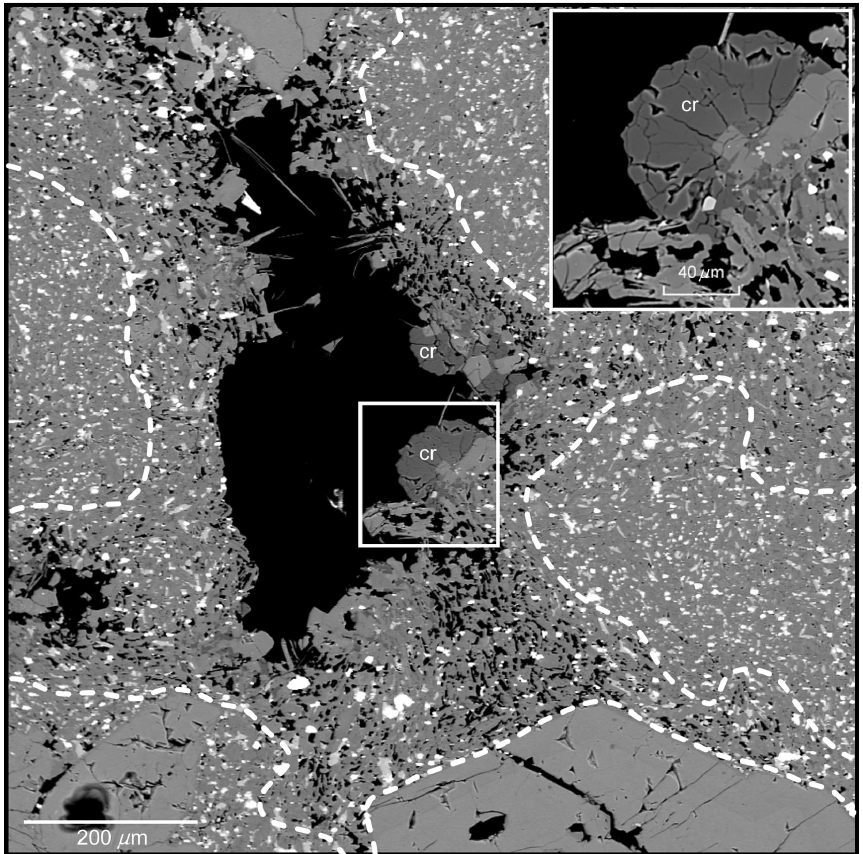
Fig. 1. Back-scatter electron images of a vesicle filling containing several patches of crystalline silica (cr), in- ferred to be cristobalite. The dashed lines indicate the approximate outline of the vesicle and interconnecting veins before the vesicle-filling assemblage was formed. Note the radial growth texture of the silica patches. The small needles sticking into the open space are F-phlogopite. Inset shows detail of one of the silica